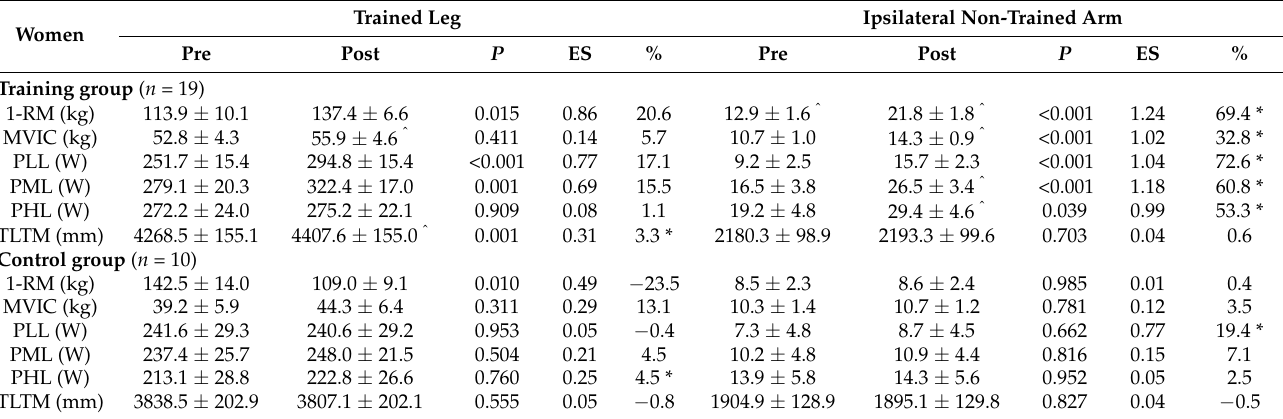
Table 2. Changes (mean ± SD) in unilateral one-repetition maximal strength (1-RM), unilateral maximal voluntary isometric contraction (MVIC), concentric mean power at low (PLL, 40% of 1-RM), medium (PML, 60% of 1-RM) and high loads (PHL, 80% of 1-RM), and total lean tissue mass (TLTM), for the trained leg (TL) and non-trained arm (NTA) for the training group and control group before (Pre) and after training (Post) in women. The p -value for the comparison between pre- and post-training values by Bonferroni test, and effect size (ES) for the changes, the magnitude of change (%) are shown for each limb.